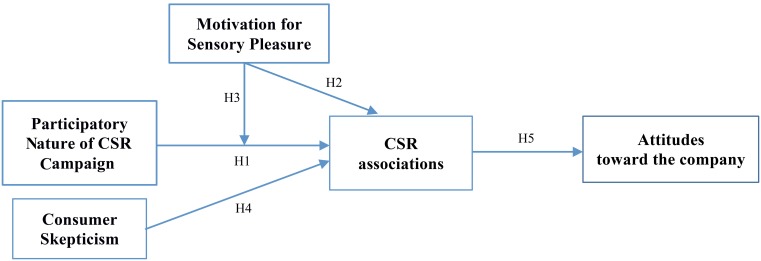
Conceptual model.